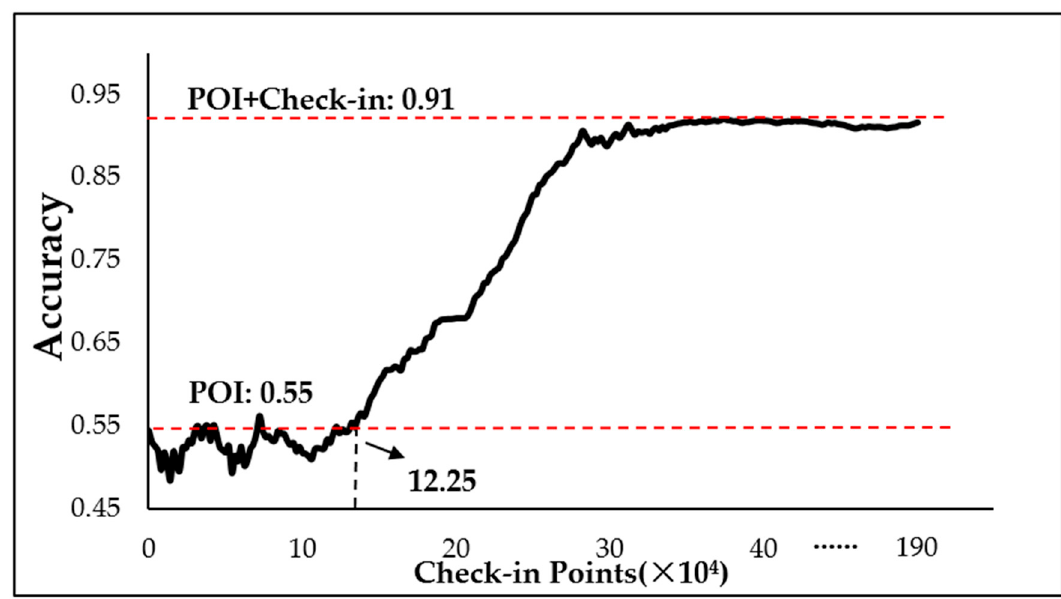
Figure 11. Relationship between check-in data volume and model accuracy ( R 2